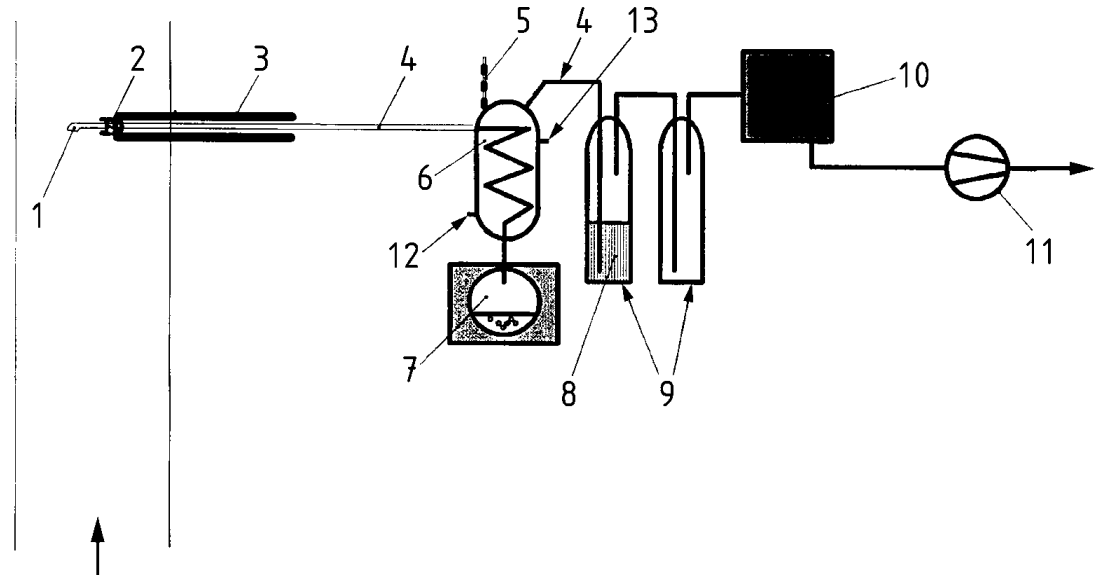
Figure 2. Diagram of the emission sampling line. 1. Nozzle; 2. Thimble filter; 3. Heated probe; 4. Glass connections; 5. Temperature control; 6. Condenser; 7. Condensate flask; 8. Diethylene glycol; 9. Solid adsorbent; 10. Drying tower; 11. Suction device; 12. Cooled water inlet; 13. Cooled water outlet.